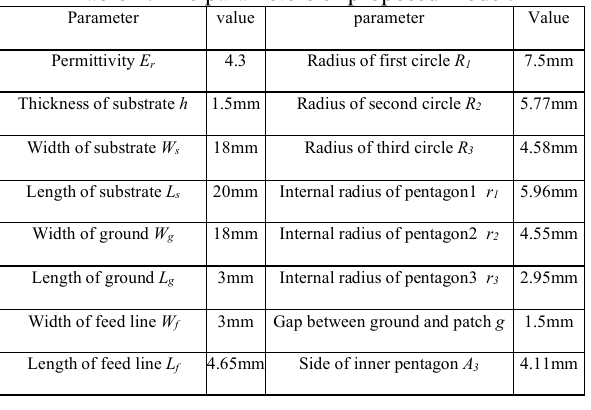
Table 1: The parameters of proposed model.